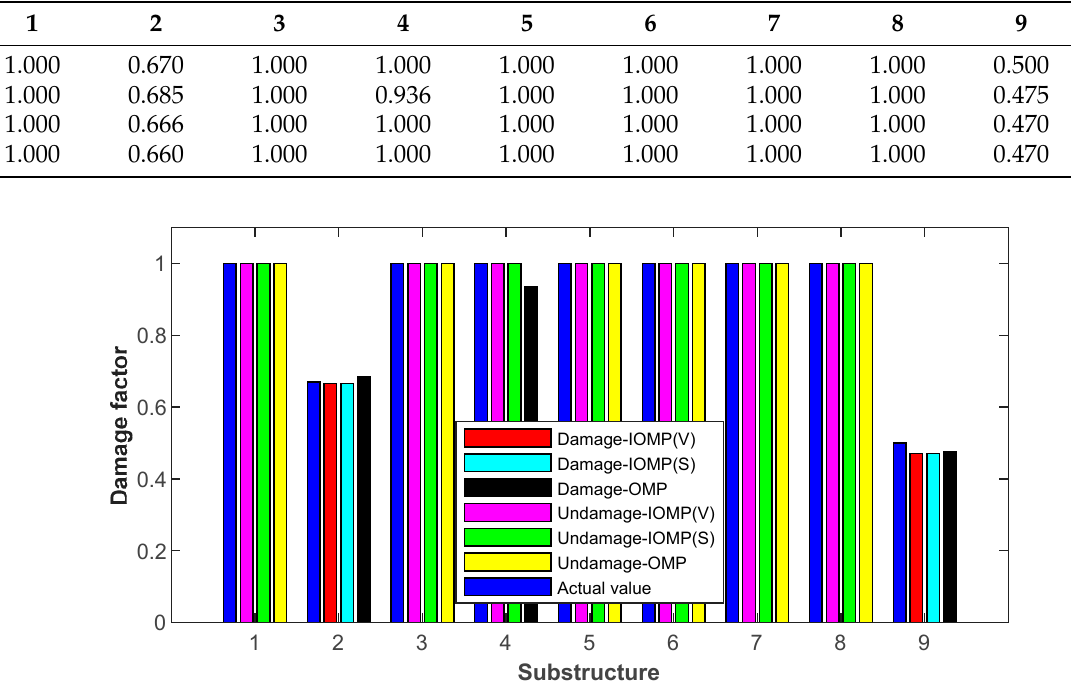
Figure 11. Damage identification results.